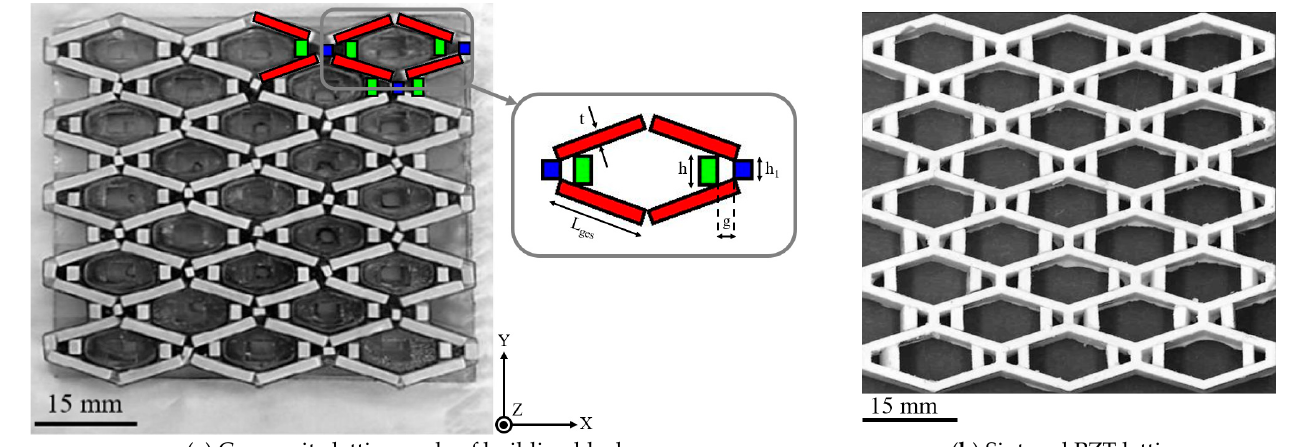
Figure 1. Fabricated PZT lattice structure constructed from ceramic building blocks in 3D-printed negative form with schematic drawing of modular unit cell ( a ) and reference structure made from the same PZT injection mold ( b ).